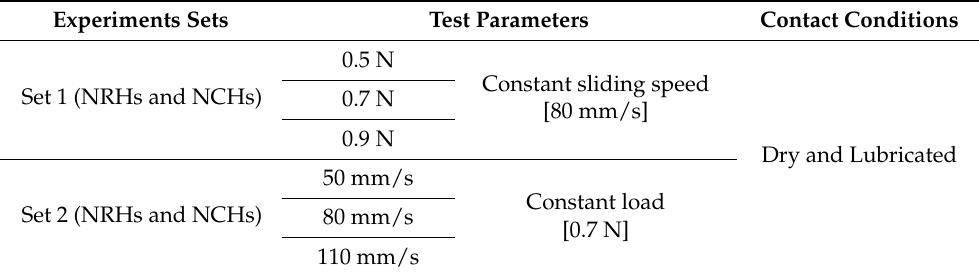
Table 1. Multi-factor sliding wear tests.